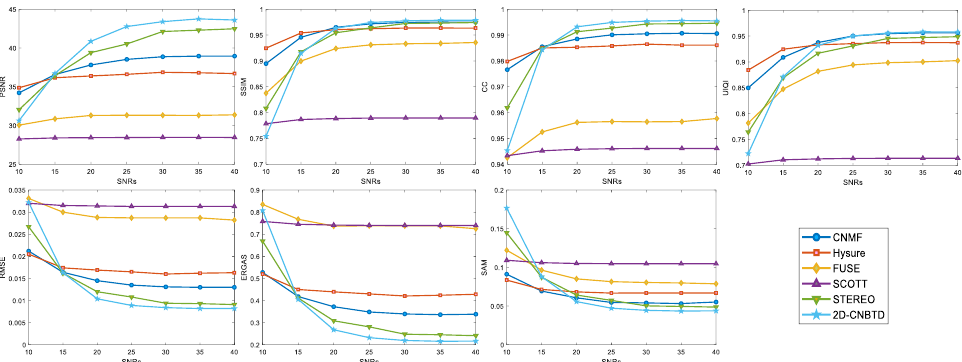
Figure 8. Plot of the change in evaluation metrics for all algorithms in the Pavia University dataset at different SNRs.